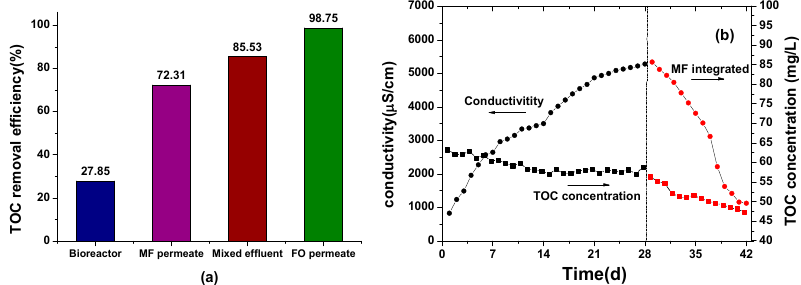
Figure 8. ( a ) TOC removal efficiency; and ( b ) variation of conductivity and TOC concentration in the bioreactor of the MF ‐ FDFO ‐ MBR hybrid system.